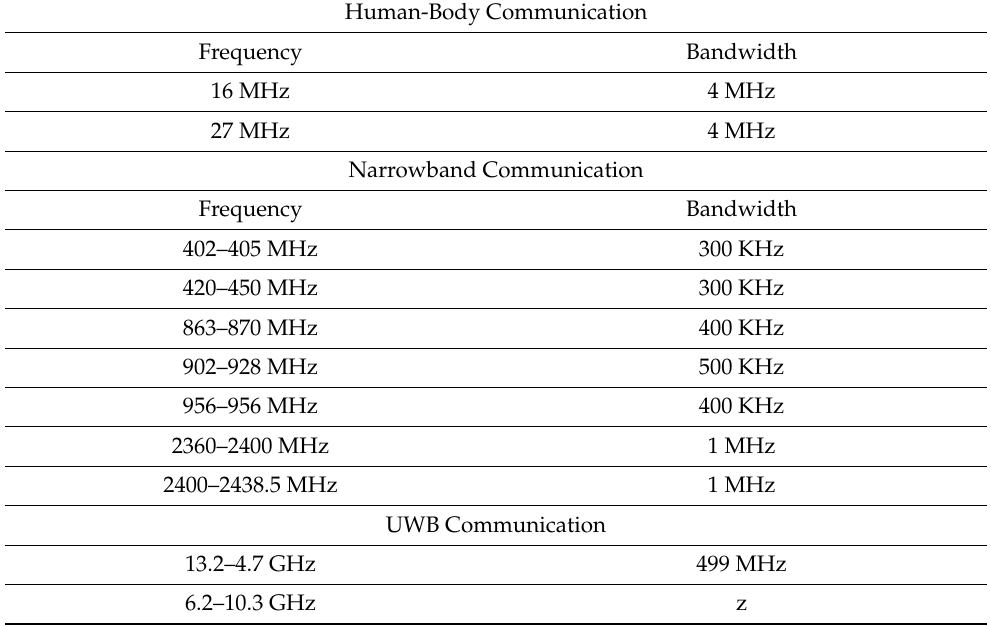
Table 4. Frequency bands of IEEE